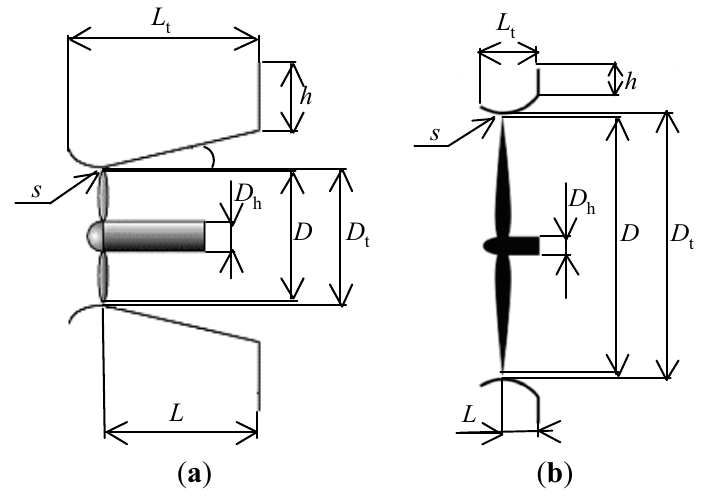
( a ) ( b ) ( c ) Figure 7. Configurations of Wind-Lens turbines: ( a ) long-type, ( b ) compact-type. See Table 2 for definitions of the symbols used in the